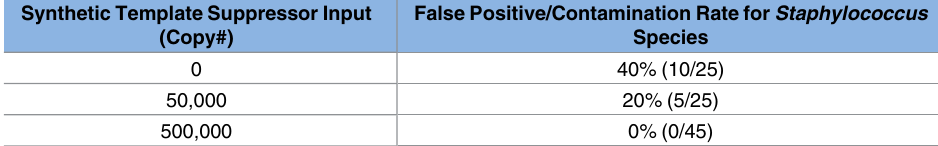
The synthetic template TufSyn2 (with input of 0, 50k and 500k copies, left column) was loaded into the